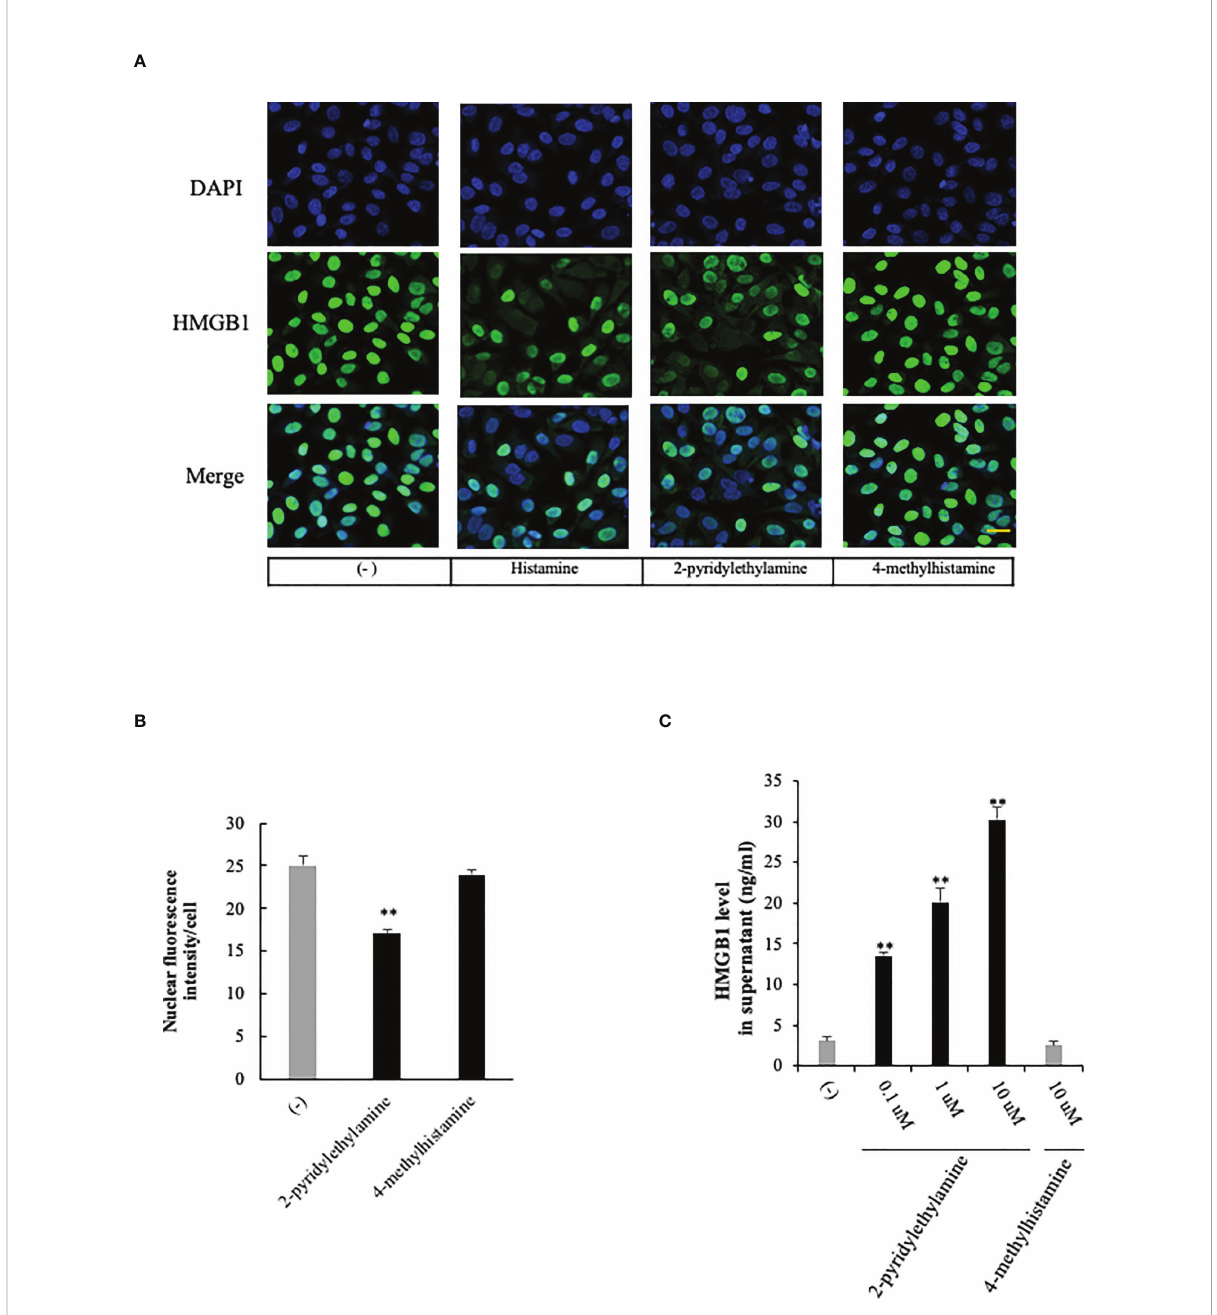
FIGURE 3 Effects of selective histamine receptor agonists on HMGB1 release from VECs. (A) EA.hy 926 cells were incubated with 2-pyridylethylamine (H 1 R- selective agonist) or 4 methylhitamine (H 2 R-selective agonist) for 6 h. HMGB1 translocation was observed with immunostaining as described in Figure 1. Scale bar=10 m m. (B) The results were quanti fi ed by ImageJ software and are expressed as the ratio of total nuclear HMGB1 intensity/cell numbers. (C) The cell culture medium was collected and the HMGB1 released into media was measured by ELISA. All results are the means±SEM of fi ve different experiments, (n=5 per group). One-way ANOVA followed by the post hoc Fisher test. **p<0.01 vs. control in the absence of